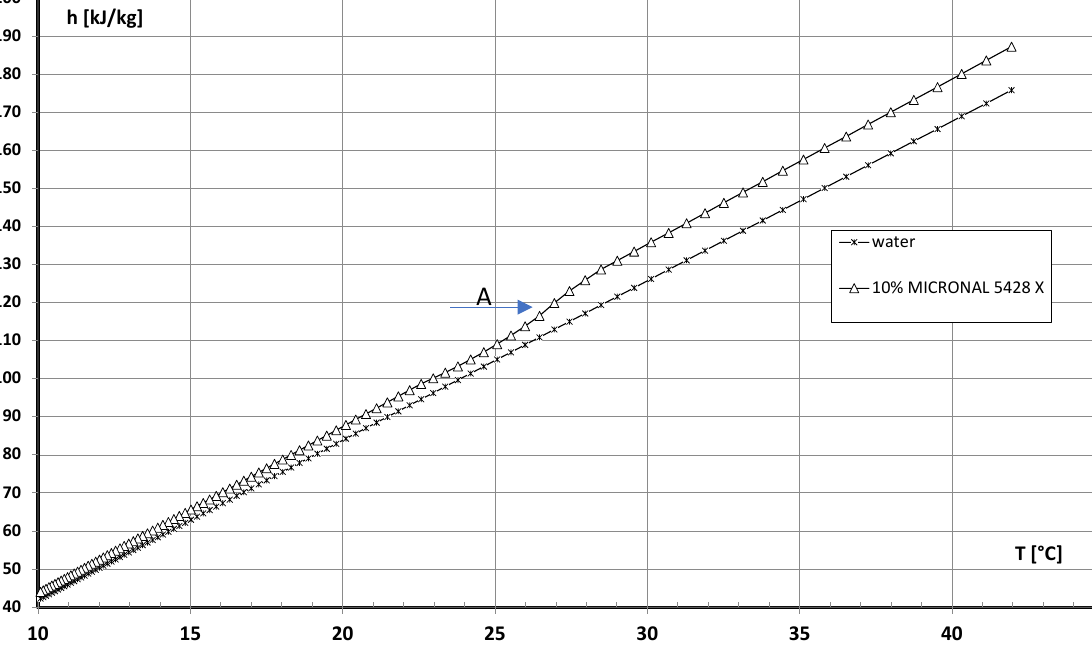
Figure 3. The dependency of the heat of fusion on the coolant inlet temperature for pure water and an aqueous solution of 10% wt. MPCM in water.